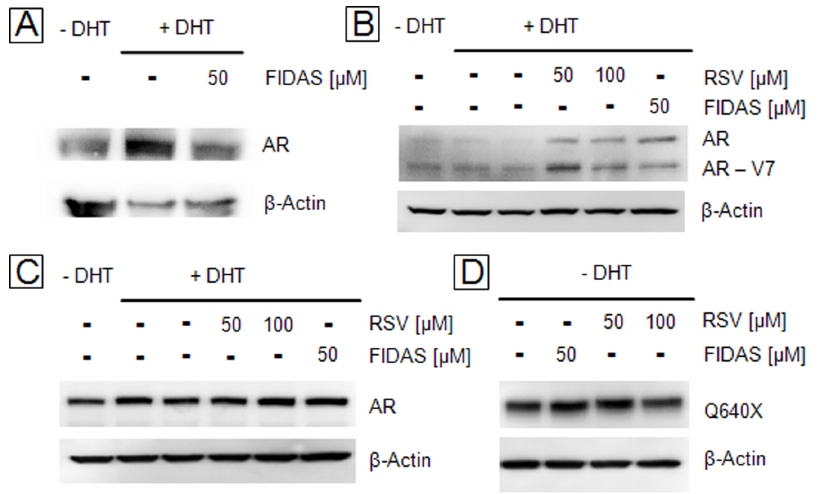
Figure 1. Regulation of AR- and AR D LBD-protein by RSV and FIDAS in human PC cell lines. Prostate cancer cells were grown in presence/ absence of DHT and incubated with RSV or FIDAS for 24 hours. Subsequently, intracellular AR or AR D LBD-levels (AR-V7, Q640X) were determined by Western Blotting as described in Material and Methods: ( A ) LNCaP, ( B ) 22Rv1, ( C ) PC-3 transfected with full length AR, ( D ) PC-3 transfected with